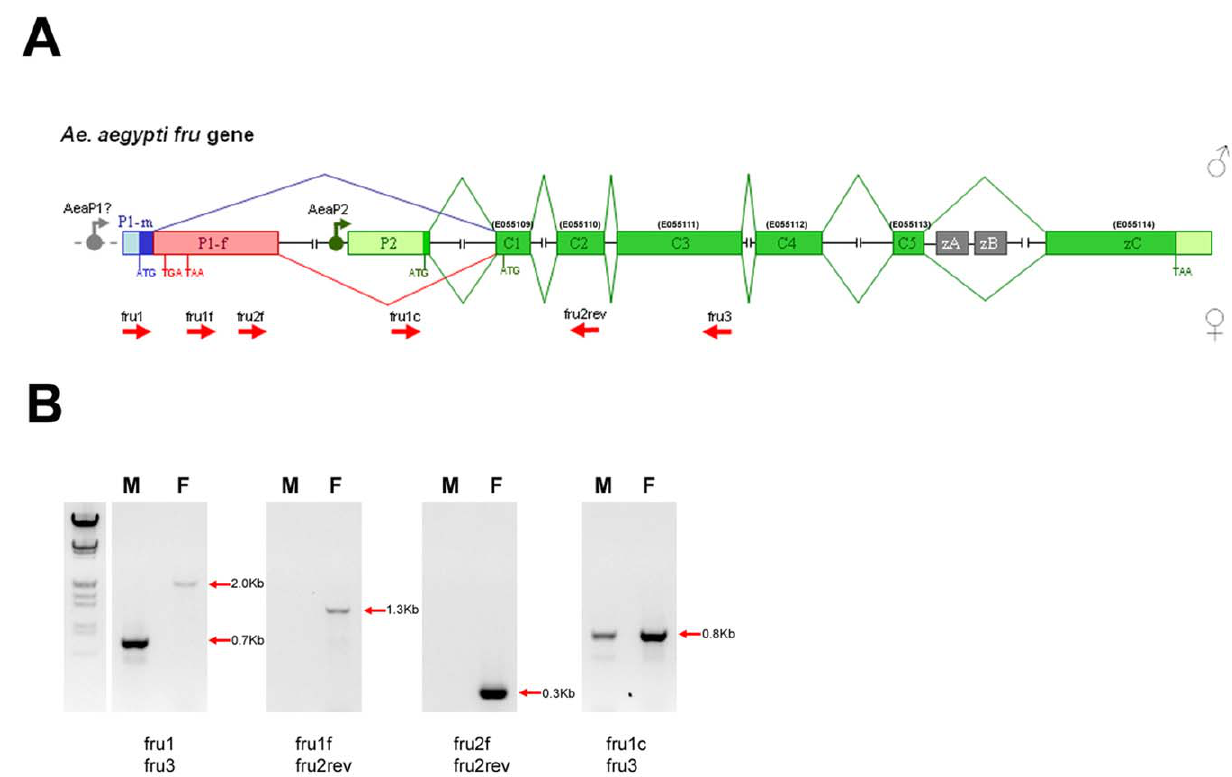
Figure 1. Aeafru gene structure. (A) Schematic drawing of the fru genomic in Ae. aegypti (not to scale). We renamed the five common Aeafru exons as C1, C2, C3, C4 and C5 and the zinc finger type C encoding exon as zC. Ensembl exon names (Ensembl id: AAEL006301) are shown in parentheses above exons. Translational start (ATG) and stop (TGA, TAA) sites are marked. The exons C1 and C2 encode the BTB domain; the exons C3, C4 and C5 encode the connecting region; the terminal exon zC encodes the type C zinc-finger domain. Exon P1 (named exon S in Demir et al., 2005) is divided in two sub-regions, a male- (P1-m in blue) and a female-specific (P1-f in pink) portion, which are alternatively spliced in a sex-specific mode. This regulation results in different 5 9 encoding regions with a male-specific ATG signal in exon P1-m and multiple stop signals in exon P1-f that lead in female to the use of a non-sex-specific ATG signal in exon C1. Exon P2 is present in both sexes and encodes a short non-sex-specific N-terminal box 8 aa long. (B) RT-PCR amplifications of Aeafru sex-specific and common cDNA fragments on sexed adult Ae. aegypti mosquitoes. Primers used in the PCR amplifications are indicated as short red arrows in Fig. 1A.